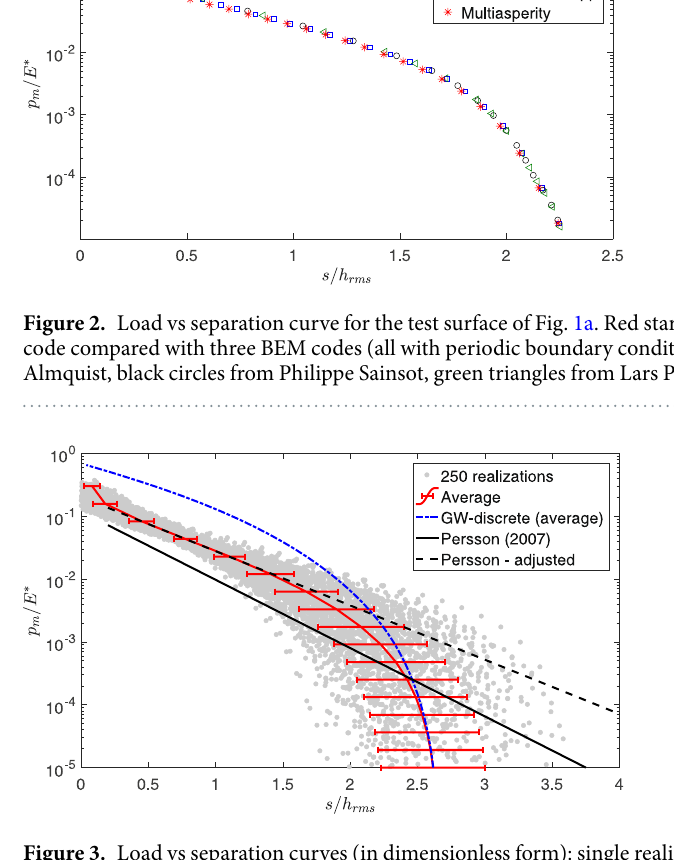
Figure 3. Load vs separation curves (in dimensionless form): single realization curves (gray dots), mean curve over the 250 realizations with error bands indicating one standard deviation (red solid line), Persson model with parameter